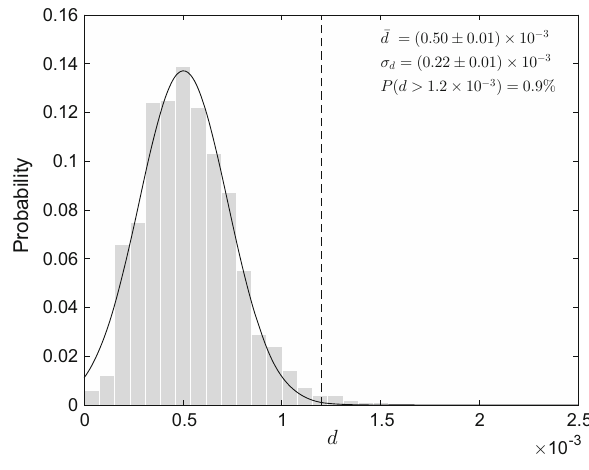
Fig. 5 The same to Fig. 1 but with the isotropic GW data